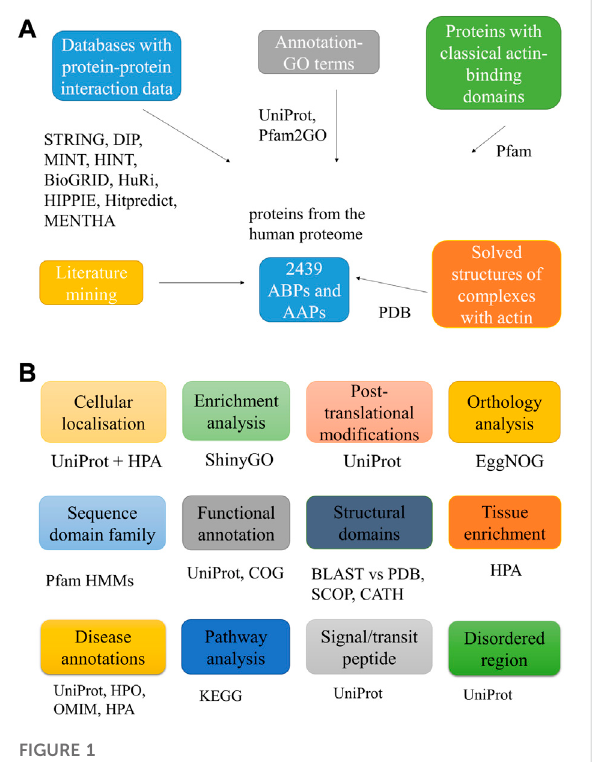
Figure 1A schematically represents the methodology for mining the AAPs, and Figure 1B lists the downstream analysis and the tools used.